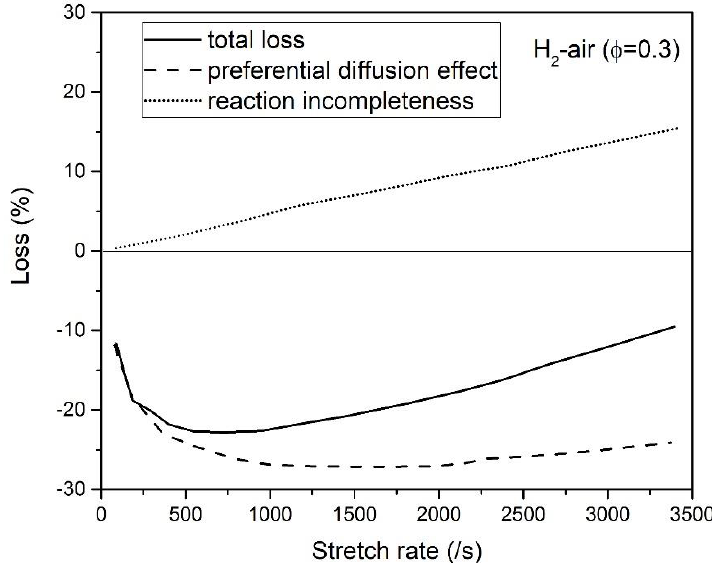
Figure 15. Variation of loss contributions as a function of stretch for lean hydrogen flame. Reproduced in Ref. [92], The Combustion Institute: 1998.